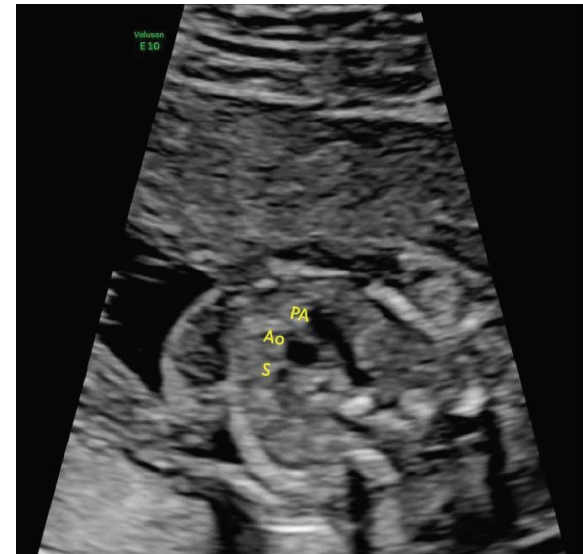
Figure 3: 2D greyscale ultrasound image of a transverse plane of the fetal thorax at the level of the great vessels, illustrating normal spacing between the pulmonary artery (PA), aorta (Ao), and su- perior vena cava (S) (legend: PA � pulmonary artery, Ao � aorta, and S � superior vena cava.).